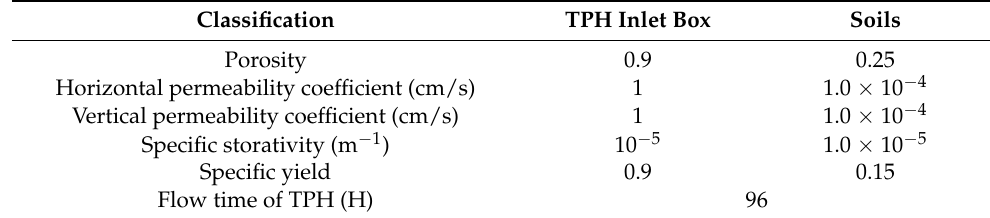
Figure 4. FDA model: ( a ) 3D view; ( b ) Plan view (modified from [32]). Table 2. FDA model conditions [32].